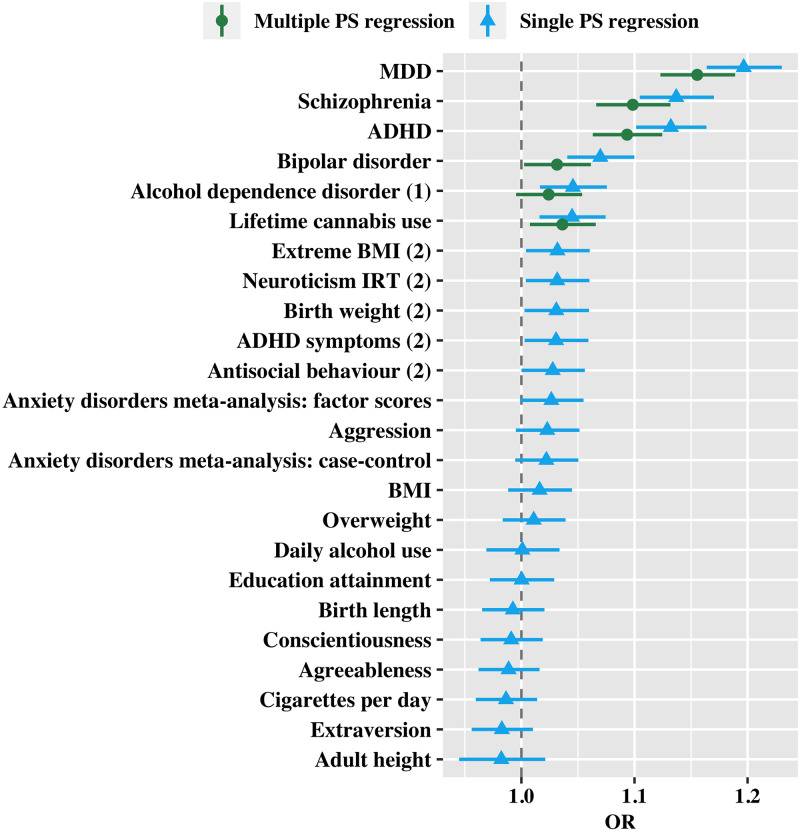
Single and multiple PS analysis of self-harm.Estimates from single PS regressions and multiple PS regression for PSs of 24 risk factors in predicting self-harm, ordered according to decreasing effect sizes. ‘(1)’ indicates not significant in multiple PS regression. ‘(2)’ indicates not significant after FDR correction. ADHD, attention deficit/hyperactivity disorder; FDR, false discovery rate; IRT, item response theory; MDD, major depressive disorder; OR, odds ratio; PS, polygenic score.